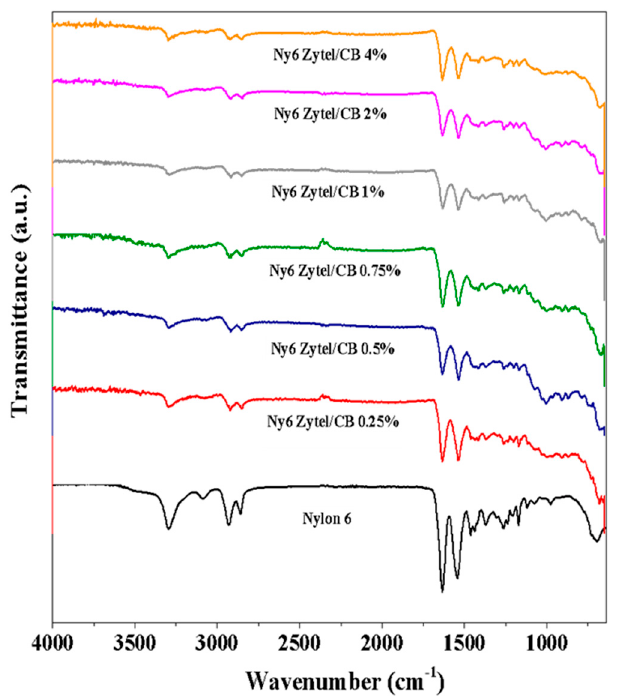
Figure 9. FT-IR spectra of Nylon 6 nonwoven and nonwoven fabrics at different concentrations (0.25, 0.5, 0.75, 1.0, 2.0, and 4.0%) after adsorption of uremic toxins.